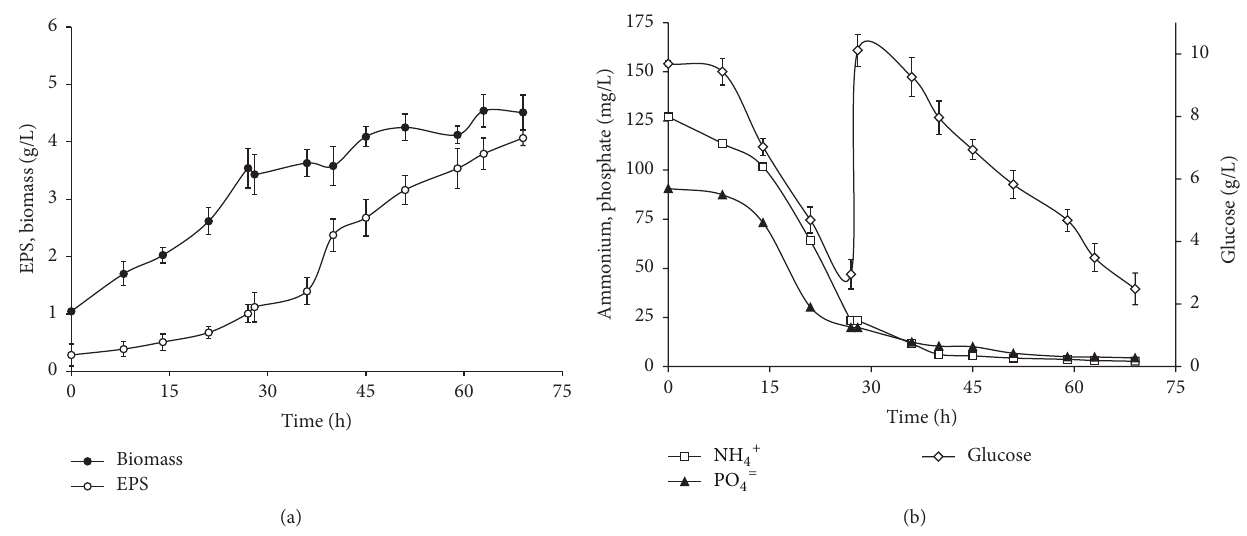
Figure 3: Fermentation profile of S. degradans with glucose as C source in NL medium at a C/N ratio of 100. (a) Biomass and EPS production. (b) Glucose, ammonium, and phosphate consumption.